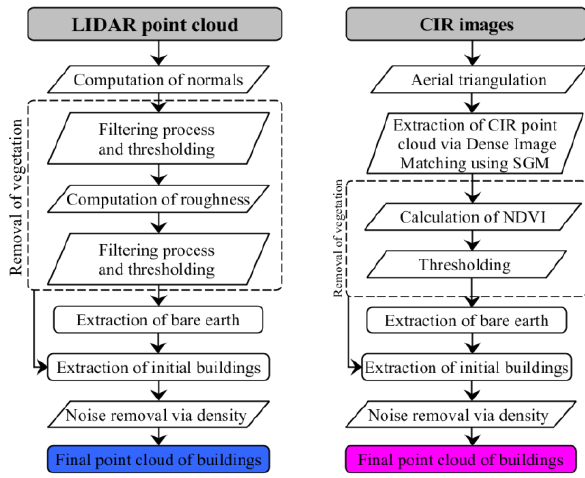
Figure 1. Workflow of the automatic detection of building points from the LIDAR point cloud (left) and the CIR point cloud